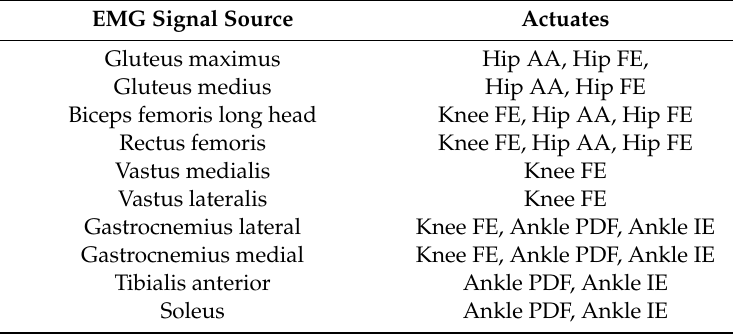
Table 1. The list of EMG signal sources and their muscle